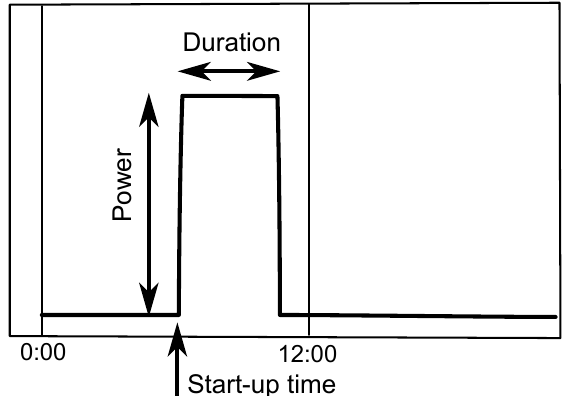
Figure 3. Block representation of the power drawn when charging the battery of a